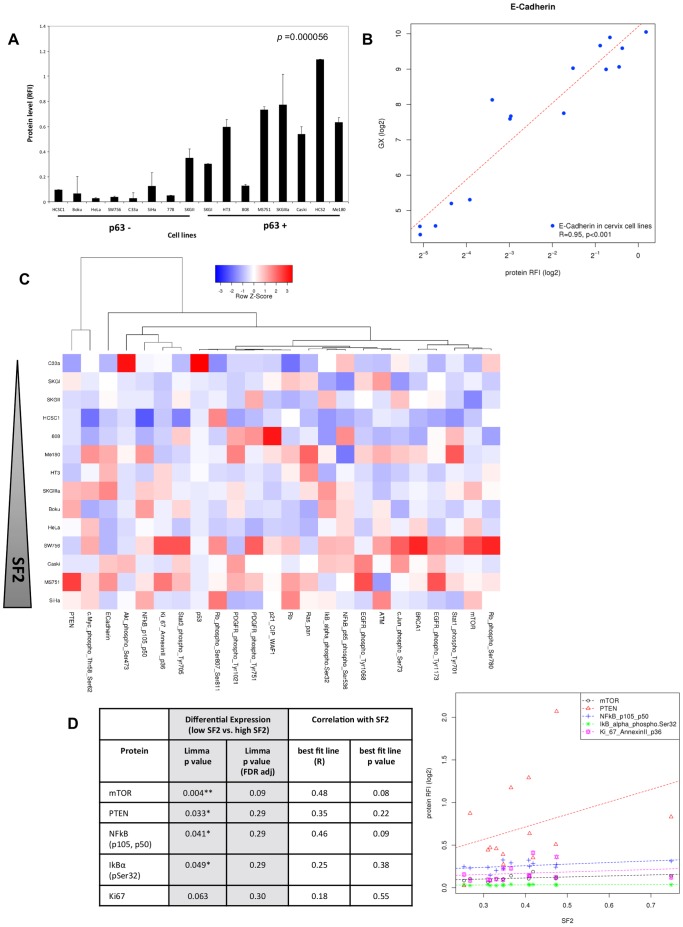
ZeptoMARK protein profiling of the cervix cancer cell lines.
A) Histogram displaying the ZeptoMARK protein-array derived abundance for the 16 cervix cancer cell lines. The y-axis displays E-cadherin protein level (relative fluorescent intensity (RFI) for each of the cell lines (x-axis). Cell lines are ranked based on TP63 expression. Grouping into p63 negative and p63 positive cell lines confirms the association of E-cadherin with p63. The p value is T-test derived comparing the difference in E-cadherin expression between the p63 positive and negative groups, error bars display standard deviation of two biological replicates. B) x–y scatterplot showing E-cadherin gene expression (Exon array) on the y-axis against E-cadherin protein expression on the x-axis. Dashed line represents perfect correlation. Exon array data-points represent the average of multiple exonic probesets (n = 19) from a single Exon expression array, where protein data are the mean of two biological replicates. C) Heatmap showing clustering of proteins with similar expression (y-axis) in the ZeptoMARK protein profiling data. Cell lines ranked by SF2. Heatmap colouring is based on row Z-score. D) xy-scatter plot showing the expression (y-axis) of the top 5 proteins from LIMMA against SF2 (x-axis). Table summarises the results of Limma differential protein expression analysis between high and low SF2 groups and Pearson correlation of protein expression (RFI) against SF2. p values denote those proteins with differential expression (* p<0.05 or ** p<0.01) between SF2 low and high groups according to LIMMA analysis. However these fail to pass false discovery rate correction.